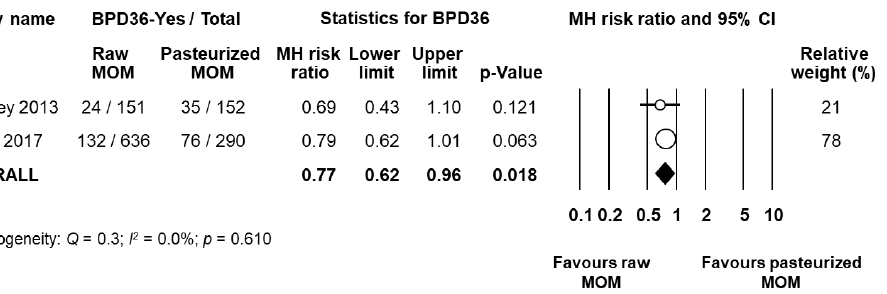
Figure 8. Meta-analysis of studies assessing the effects of receiving raw MOM vs. receiving pasteurized MOM, on risk of BPD36. Circles (O) represent the effect sizes per study, and their size represents the relative weight of the study in the meta-analysis. Diamonds ( ◆ ) represent the pooled effect size. MOM: mother’s own milk; BPD36: bronchopulmonary dysplasia defined as oxygen dependency at 36 weeks post-menstrual age; MH: Mantel-Haenszel.